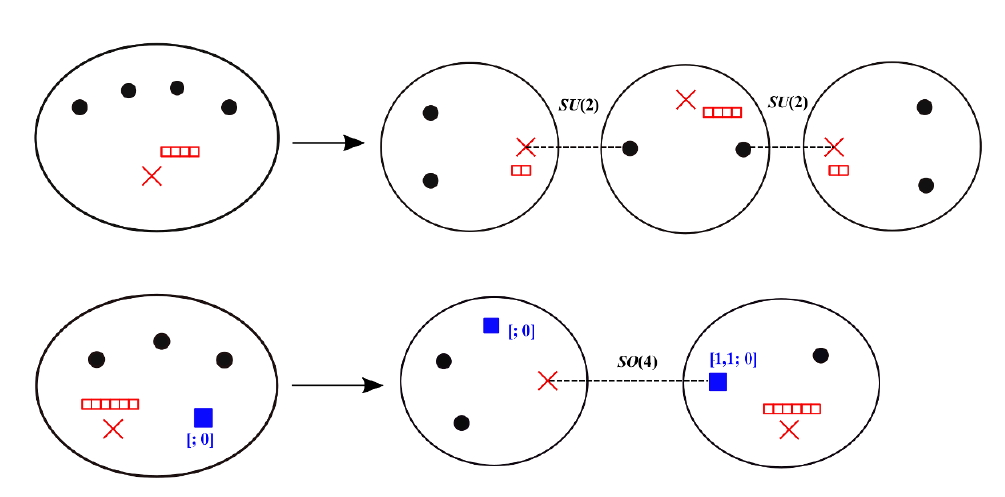
Figure 5 . Comparison of S duality from A 3 (upper half) and D 3 (lower half) perspective. From the A 3 point of view, each black dot is given by [1], and the new red marked point after degeneration is given by SU(2) puncture [1 ; 1]. The two theories on the left and right sides are ( A 1 ; D 2 k +2 ) theory, which is given by irregular puncture whose T k +2 ; : : : ; T 1 = [1 ; 1], and one regular puncture. The (cid:2) ( k +1) ; [1 ; 1 ; 1 ; 1] theory in the middle is ( III [2 ; 2] ; F ) theory. Here F denotes maximal puncture. From k; 1 the D 3 point of view, two ( A 1 ; D 2 k +2 ) theories combine together and form a D 2 type theory. The (cid:2) ( k +1) ; [1 3 ;0] theory on the right is ( III [1;4] k;